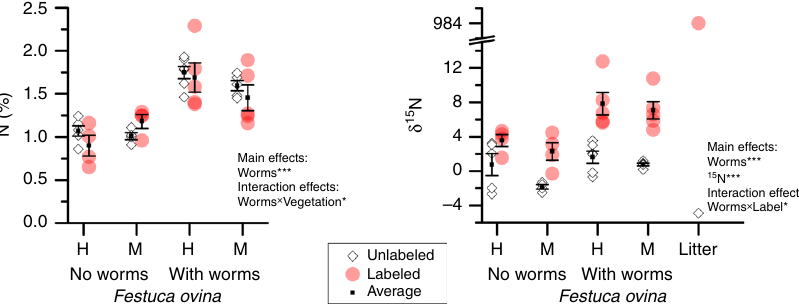
Fig. 2 Earthworm effects on nitrogen uptake of Festuca ovina . Shown are earthworm effects on N content (%) and δ 15 N of Festuca ovina , a plant present in both of the studied vegetation types, i.e., heath (H) and meadow (M). Individual replicates of samples from unlabeled (white diamond shape) and δ 15 N labeled (red circle, where darker values indicate overlapping data) mesocosms are shown with average values (black square, ±std. err). Main effects and interaction effects are presented as text for each panel (effect of the labeled litter is indicated using the 15 N symbol) along with symbols indicating signi fi cance level ( P < 0.05 are shown using *, and signi fi cance levels <0.001 are indicated as ***). Note the cut off in the y -axis to show the δ 15 N signatures of the unlabeled and the labeled litter. Source data are provided as a Source Data fi le.